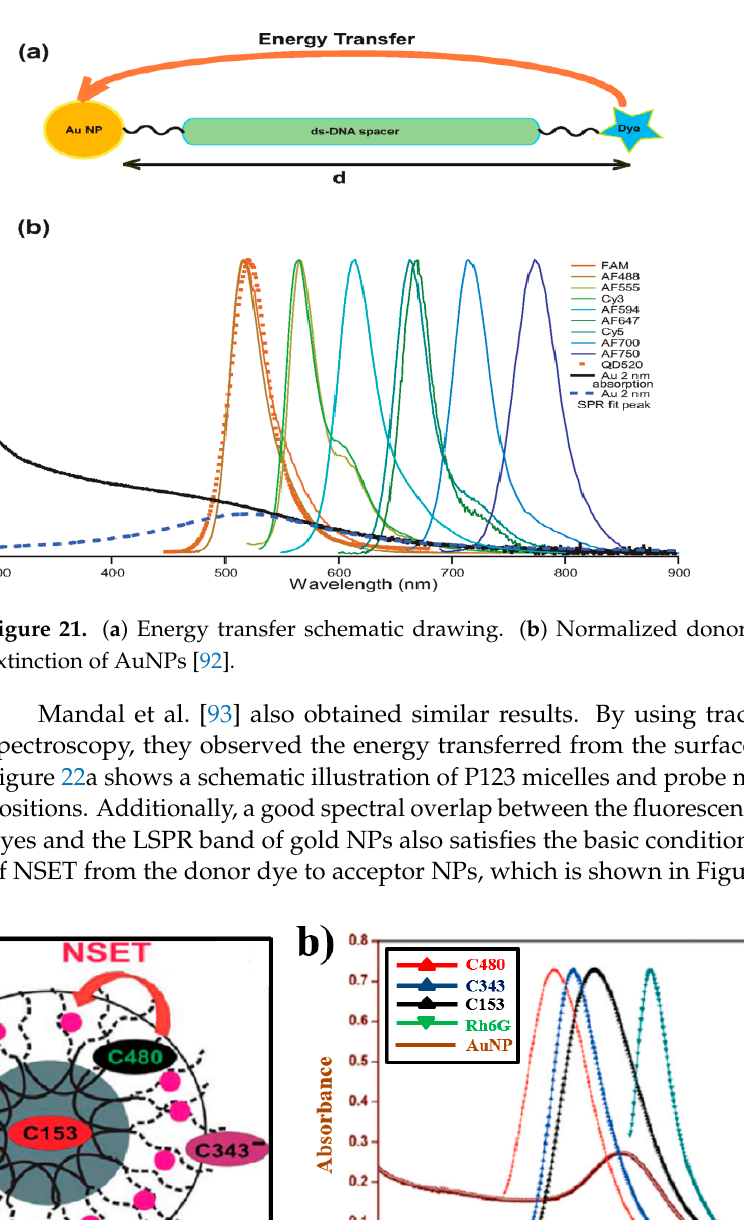
17 of 44 Figure 20. Schematic illustration of a novel SET biosensor system [89]. Simultaneously, David(cid:31)s [90] group and Vollath(cid:31)s [91] group explored the in fl uence of both particle shape and size on surface energy, and they concluded that there exists only a minor dependence on the NP size. Related research is also deepening. Singh et al. [92] explored the spectral overlap of LSPR in the energy transfer process between the dye and gold NPs in the wavelength range of 520 nm to 780 nm. When the fl uorescence of the